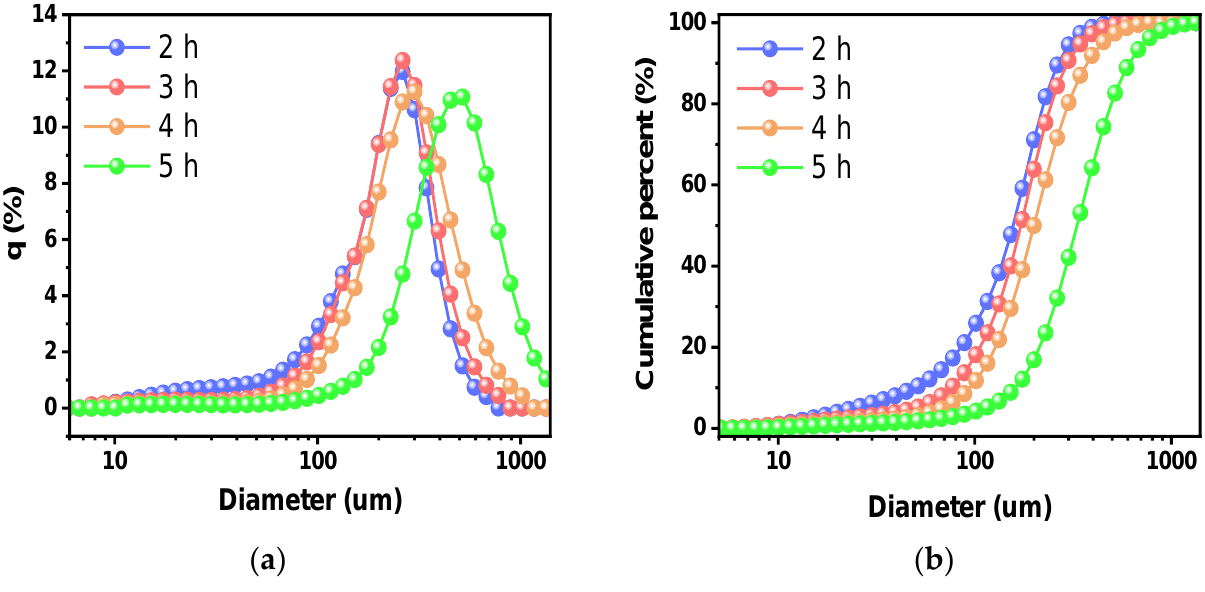
Figure 6. Dependency of size distribution of as-synthesized powder on gelation time ranging from 2 to 5 h. ( a ) Particle size distributions. ( b ) Cumulative particle size distributions. Table 1. Dependency of size distribution characteristics on gelation time.